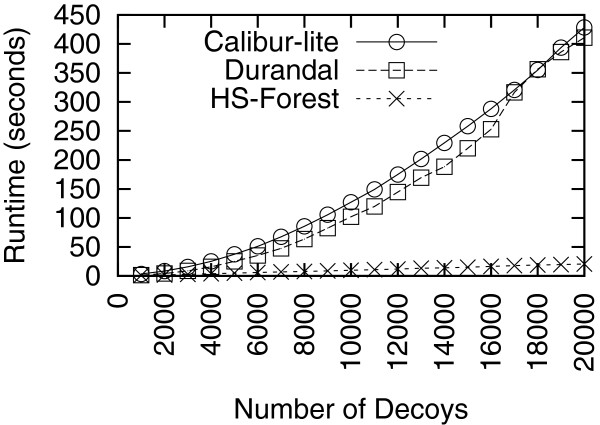
Runtime on the 1shfA decoy set. The size varies from 1,000 to 20,000 structures.